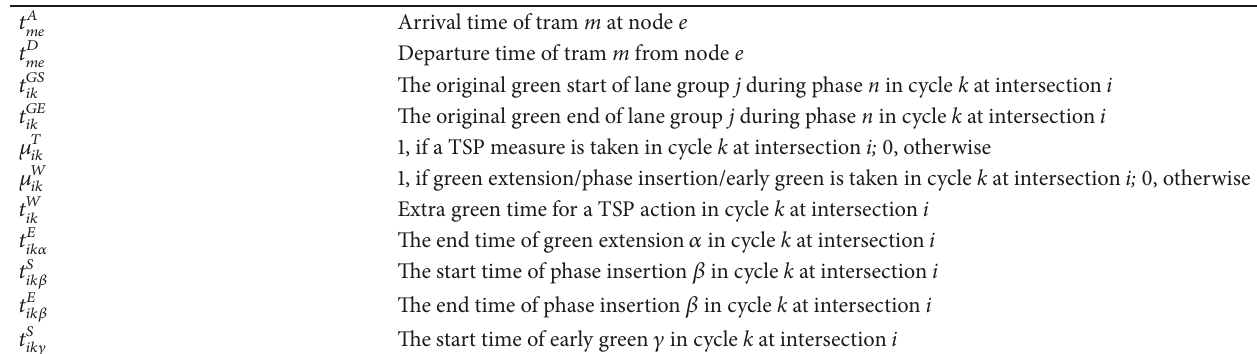
Table 1: Decision